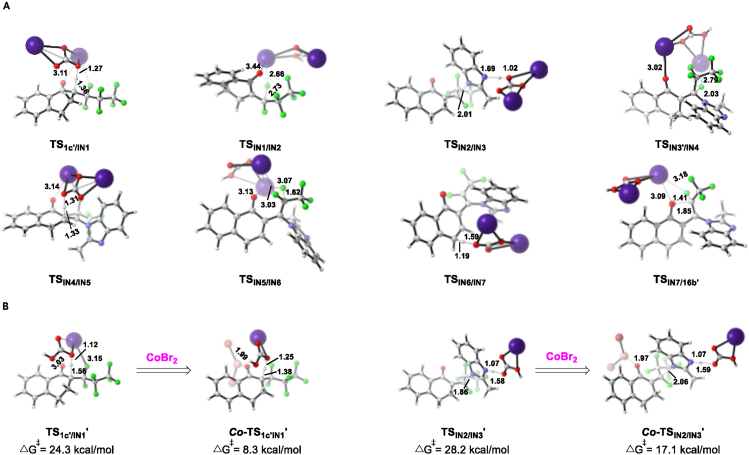
Optimized Transition State Structures(A) Optimized transition state structures (distances are in Å).(B) Transition state structures of CsHCO3-mediated deprotonation of 1c′ and N-nucleophilic addition step of IN2 without or with CoBr2.